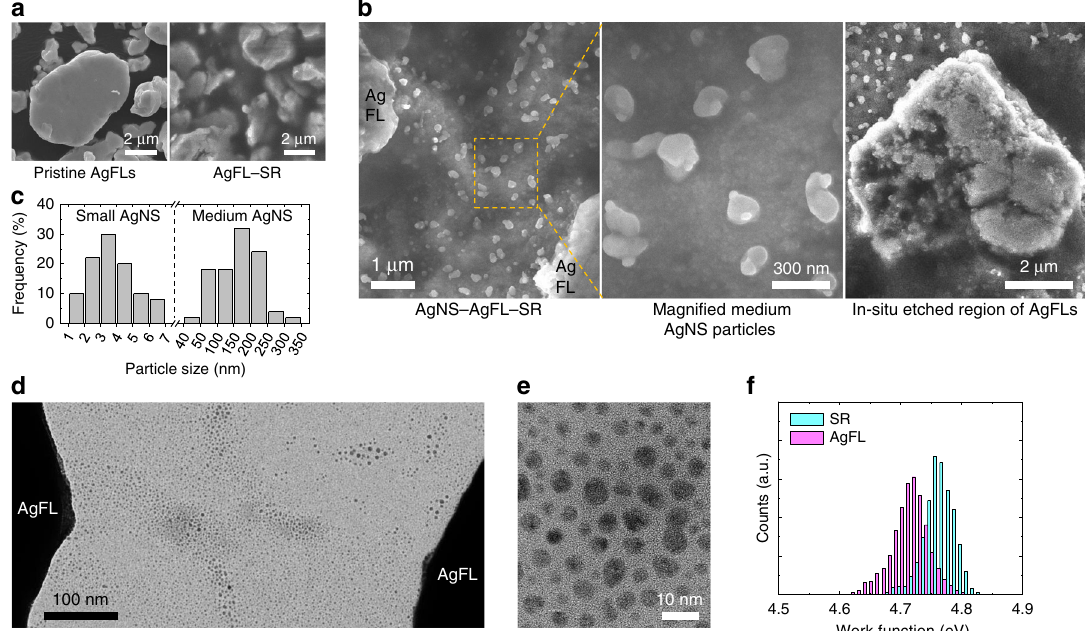
Fig. 2 Characterization of medium and small AgNS particles. a, b SEM images of the AgFL-SR (Ag = 44 vol%, THF = 15 mL) and AgNS-AgFL-SR (Ag = 44 vol%, THF peroxide = 15 mL) nanocomposites without heating. c Size distribution of small and medium AgNS particles. The sum of each frequency is 100%. d, e TEM images of small AgNS particles (THF peroxide-treated AgFLs). The polymer was excluded to get clear images. f Work function distribution of pure SR and